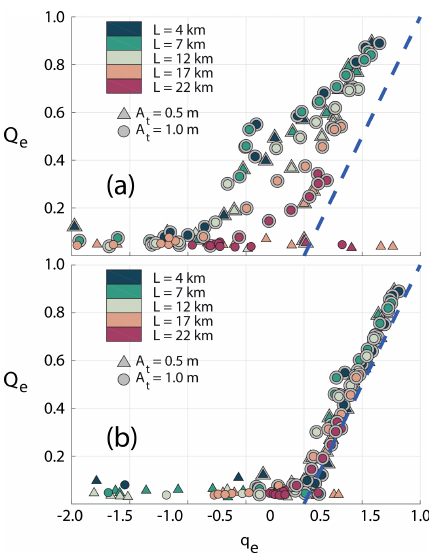
Figure 19. The effective transport Q e from the simulations (Eq. 19) plotted against the effective transport resulting from the simple kinematic model (Eq. 30) for (a) X d = 1 and (b) X d = 1 . 67. The dashed line indicates Q e = q e . Dipoles, recognized from the crite- ria given in Sect. 5, are marked with a gray